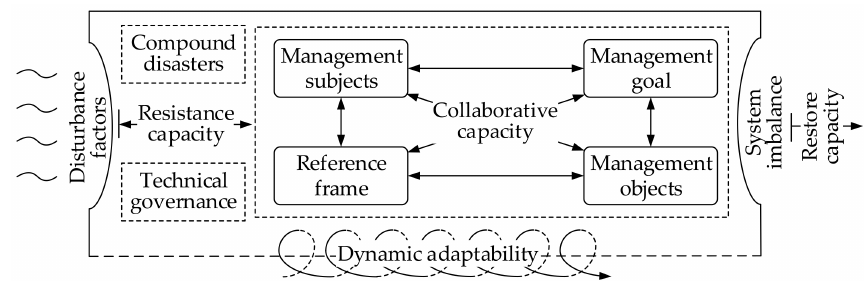
Figure 2. Concept model of local emergency